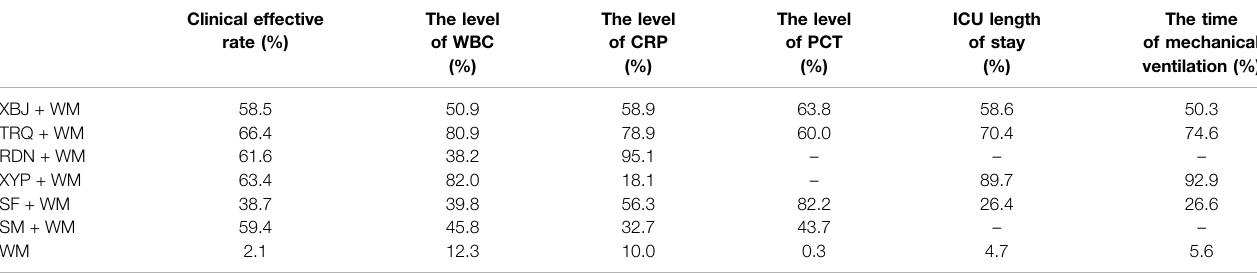
TABLE 8 | SUCRA results of the outcomes.